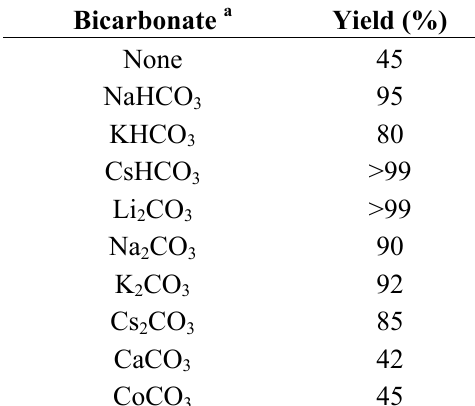
Table 1. Carbonate- and bicarbonate-catalyzed acetylation of 4-nitrobenzyl alcohol. Bicarbonate